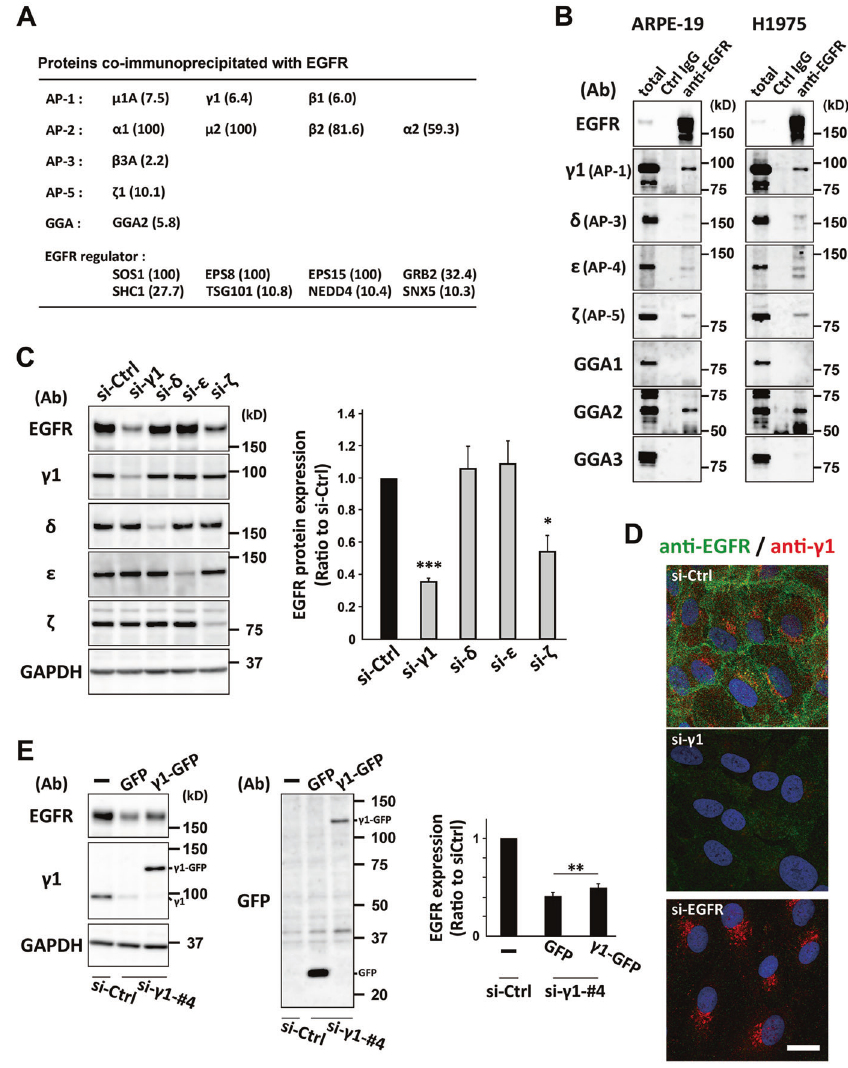
Fig. 1 AP-1-depletion causes a reduction in EGFR protein. A A list of proteins co-immunoprecipitated with EGFR is shown. Clathrin adapter molecules and other EGFR regulators are extracted from Supplementary Table S1 and shown with their corresponding abundance ratio (anti- EGFR IgG/normal IgG) in parenthesis. B Immunoprecipitation of ARPE-19 and H1975 cell lysates with control (Ctrl) IgG or anti-EGFR antibodies. Approximately 0.8% of the input (total) and bound proteins were analyzed by western blotting with the indicated antibodies (Ab). C Western blotting of lysates of ARPE-19 cells transfected with siRNA for control (si-Ctrl), γ 1-adaptin (si- γ 1), δ -adaptin (si- δ ), ε -adaptin (si- ε ), or ζ -adaptin (si- ζ ); the indicated antibodies (Ab) were used. The ratio of each siRNA to si-Ctrl was plotted on the right as mean ± SD (of three experiments). Statistical differences between each siRNA and si-Ctrl were analyzed using Student ’ s t -test (* P < 0.05, *** P < 0.001). D Double- immuno fl uorescence microscopy of cells treated with si-Ctrl, si- γ 1, or siRNA for EGFR (si-EGFR) and incubated with anti-EGFR (green) and anti- γ 1-adaptin (red) antibodies. Nuclei were stained with Hoechst 33342 (blue). Bar, 20 μ m. E ARPE-19 cells treated with si- γ 1-#4 that targets 3 ′ UTR of the γ 1 gene, were transfected with a plasmid encoding GFP or γ 1-GFP devoid of the 3 ′ UTR, or without plasmid ( – ), and then analyzed by western blotting with the indicated antibodies (Ab). The ratio of each group to si-Ctrl was plotted on the right as mean ± SD (of four experiments). The statistical difference between GFP and γ 1-GFP was analyzed using Student ’ s t -test (** P <